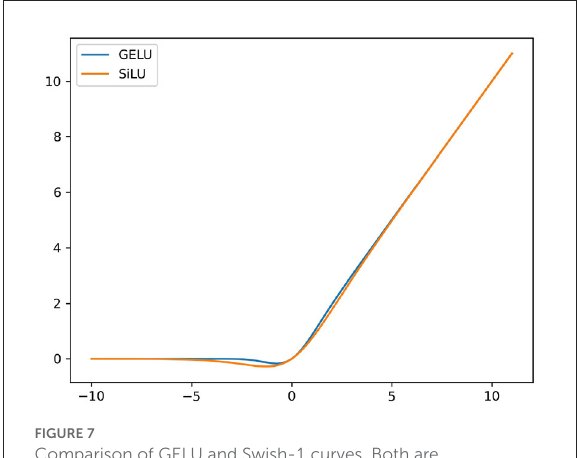
FIGURE7 Comparison of GELU and Swish-1 curves. Both are non-monotonic functions and have similar shapes. When the input values are around zero, most outputs from GELU are greater than Swish-1 which makes the non-monotonic bump of Swish-1 wider than the other.